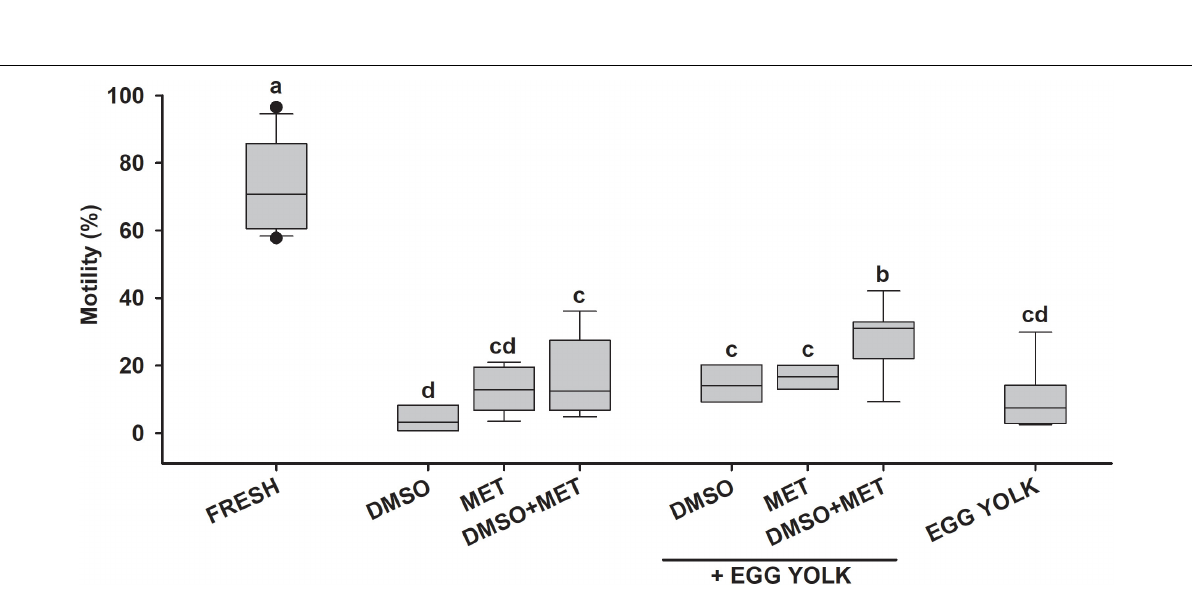
FIGURE 6 | Motility after cryopreservation in sharks. Motility results for cryopreservation protocols in small spotted catshark ( n = 11). Sperm obtained from Scyliorhinus canicula was diluted with artificial elasmobranch seminal plasma extender (EE) and frozen using different cryoprotectant combinations: dimethyl sulfoxide (DMSO), methanol (MET) and fresh egg yolk. FRESH represents the motility and viability values in fresh sperm samples prior to freezing. Different letters mean significant differences between motility values from each